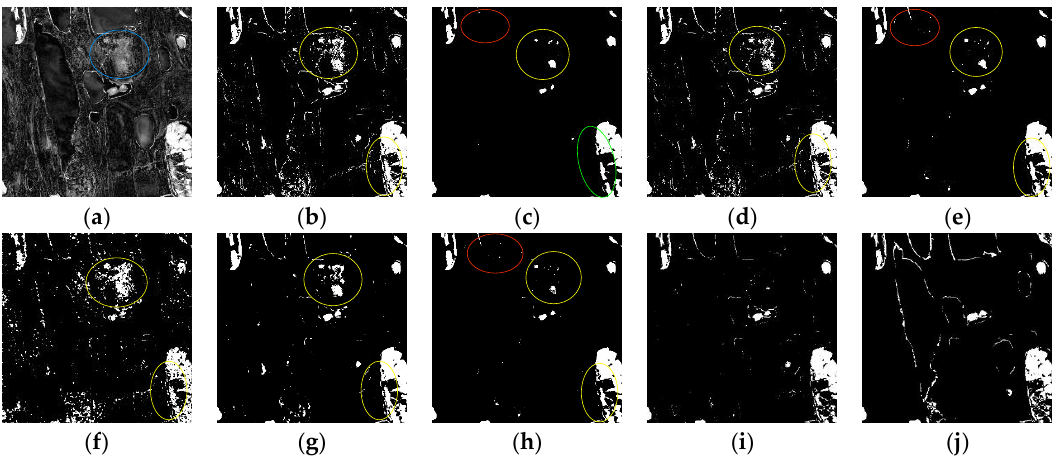
Figure 10. Results of the Alaska dataset. ( a ) Difference image, the blue ovals refer to the local brightness deformation region. ( b ) KI. ( c ) MRF+EM. ( d ) FCM. ( e ) FLICM. ( f ) GA-mask. ( g ) GA-FCM. ( h ) MOEA/D. ( i ) Proposed M-DECD. ( j ) Reference map.